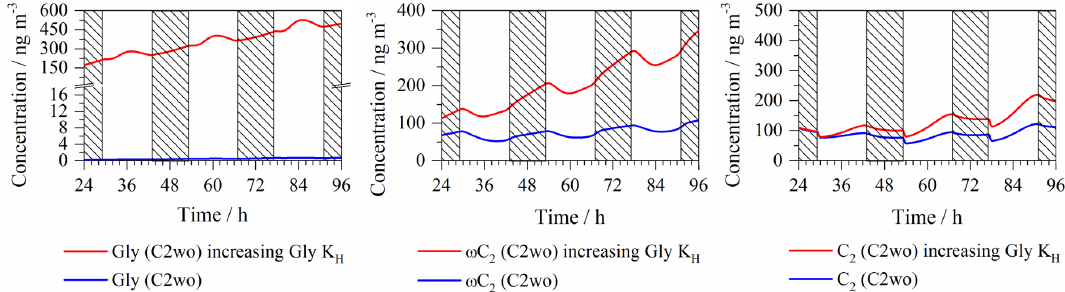
Figure 10. Concentration variations in modeled Gly, ω C 2 and C 2 when increasing the Gly Henry’s law constant by 2 orders of magnitude (shadow: night; K H : Henry’s law